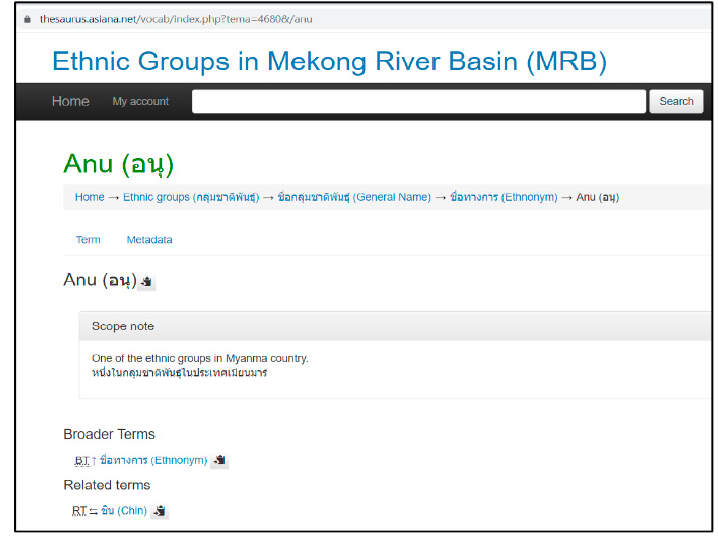
Figure 6. Search results for the term “Anu” with scope note, BT, and RT.